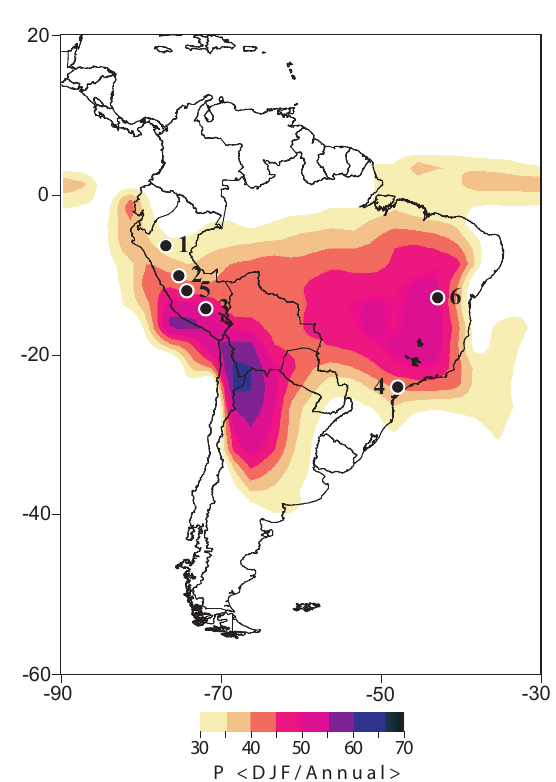
Fig. 2. Percentage of annual precipitation falling during the ma- ture stage of the South American summer monsoon (DJF), based on CMAP data (1979–2004). Numbers indicate location of high- resolution stable isotope records within the monsoon belt: 1: Cas- cayunga cave; 2: Laguna Pumacocha; 3: Quelccaya Ice Cap; 4: Cristal cave; 5: Huagapo cave; 6: Diva de Maura and Torrinha